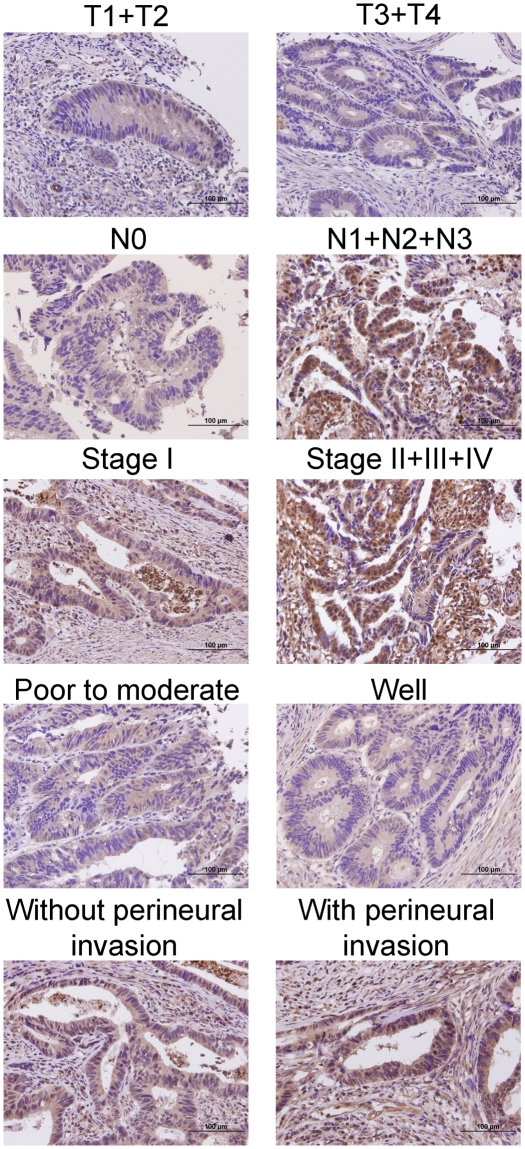
The representative IHC nuclear CK2α staining corresponding to
mean nuclear CK2α labeling index values for different
parameters.Magnification: 400×.